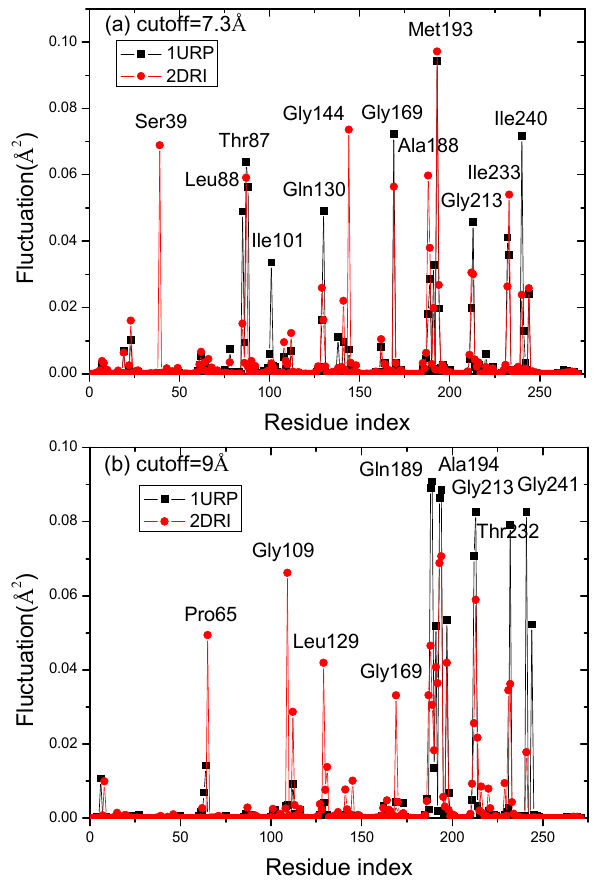
Figure 8. The mode shapes as averages of the fastest 10 modes of the two structures for = 7.3 Å ( a ) and r = 9 Å ( b two cases: r cutoff cutoff